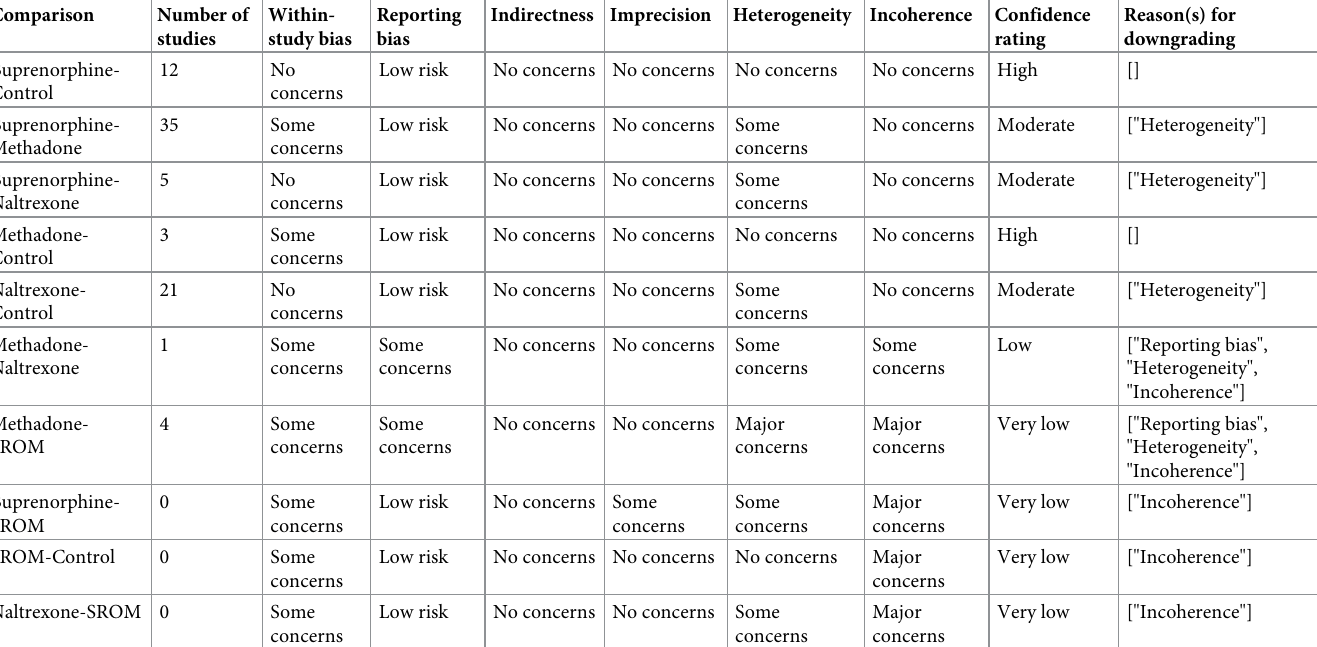
Table 4. Summary of credibility of the network estimates using the Confidence in Network Meta-Analysis (CINeMA)